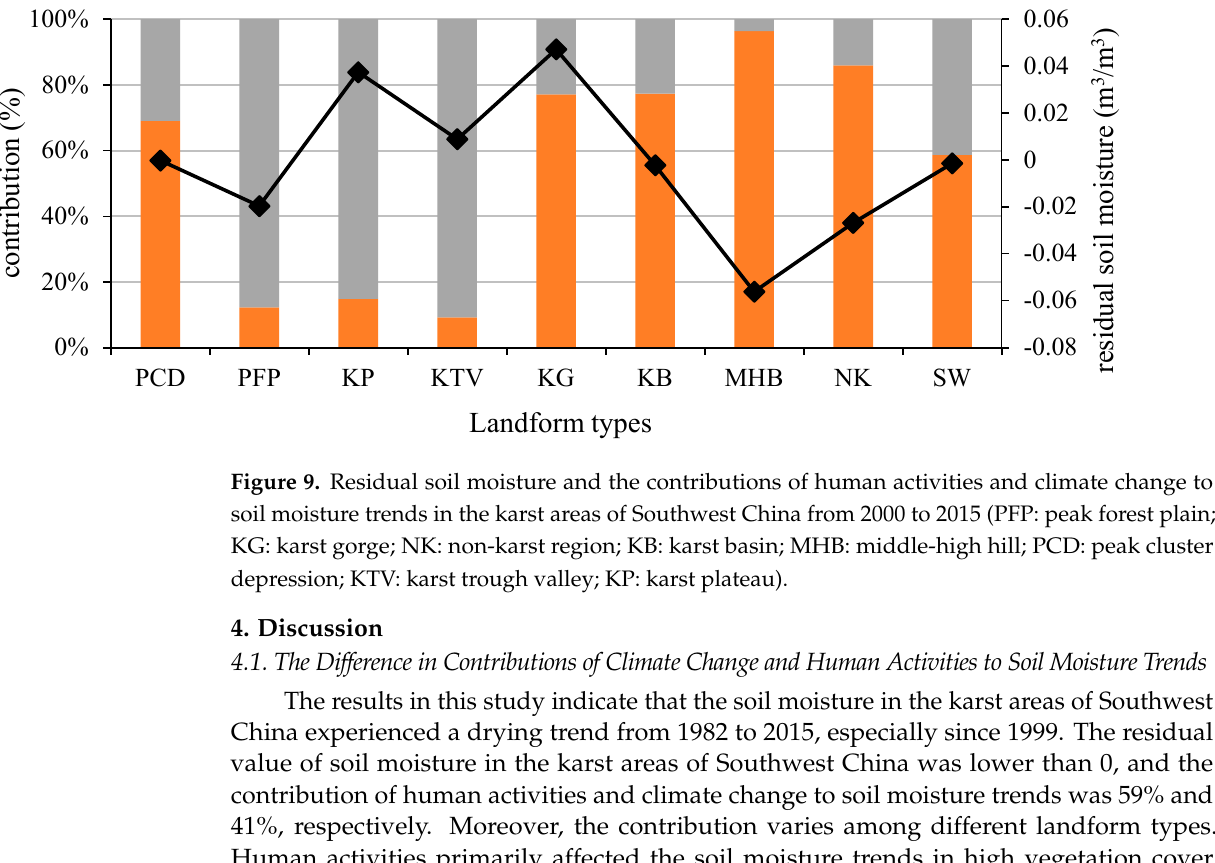
Figure 8. Residual soil moisture in the karst areas of Southwest China from 2000 to 2015 (PFP: peak forest plain; KG: karst gorge; NK: non-karst region; KB: karst basin; MHB: middle-high hill; PCD: peak cluster depression; KTV: karst trough valley; KP: karst plateau).